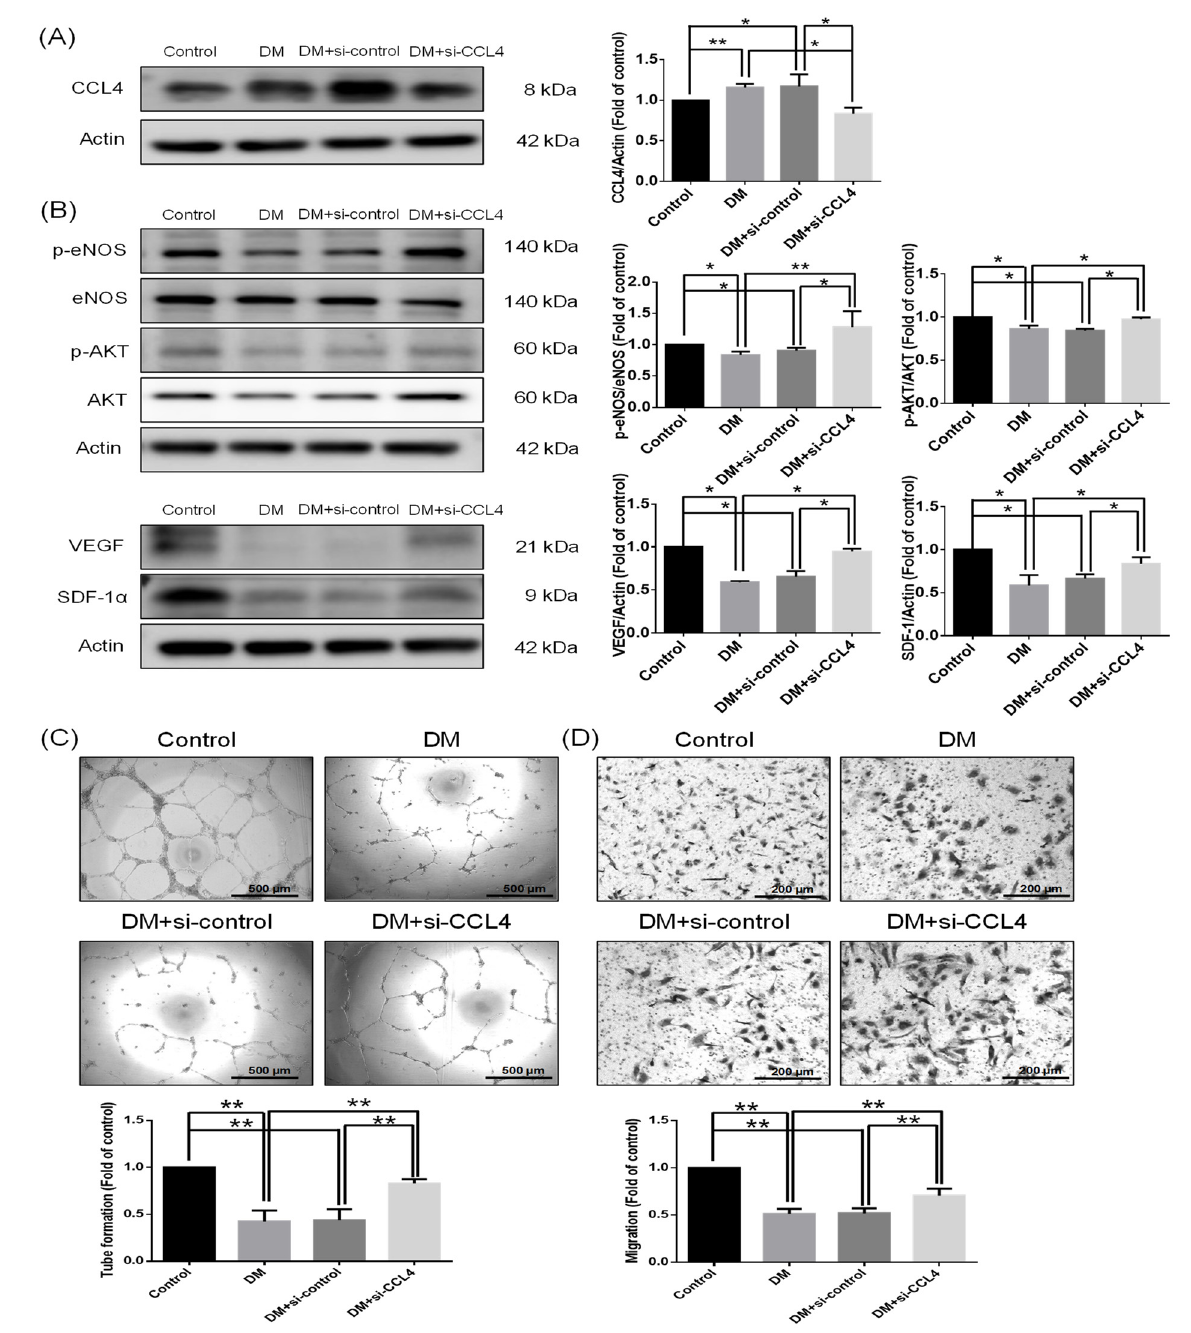
Figure 2. CCL4 inhibition by siRNA recovered functions of EPCs from type 2 DM patients with increased angiogenic protein expressions. Western blotting and statistical analyses of CCL4 (( A ); n = 3), p-AKT, p-eNOS, VEGF, and SDF-1 α . The angiogenic proteins were reversed after the administration of siCCL4 (( B ); n = 3). Tube formation ability and quantitative analysis of EPCs from type 2 DM patients and control subjects; the images were captured using a ( × 40) microscope. The tube formation ability was improved after the administration of siCCL4 (( C ); n = 3). Migration ability and quantitative analysis of EPCs from type 2 DM patients and control subjects; the images were captured using a ( × 100) microscope. The migration ability was improved after the administration of siCCL4 (( D ); n = 3). * p < 0.05, ** p < 0.01.